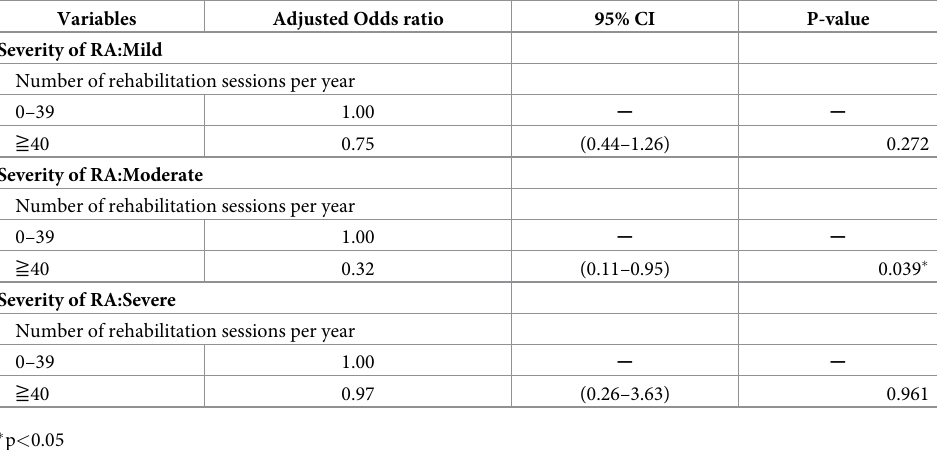
Table 3. Adjusted odds ratio of stroke associated with number of rehabilitation sessions per year, stratified by dis- ease severity of RA in the multivariable logistic regression